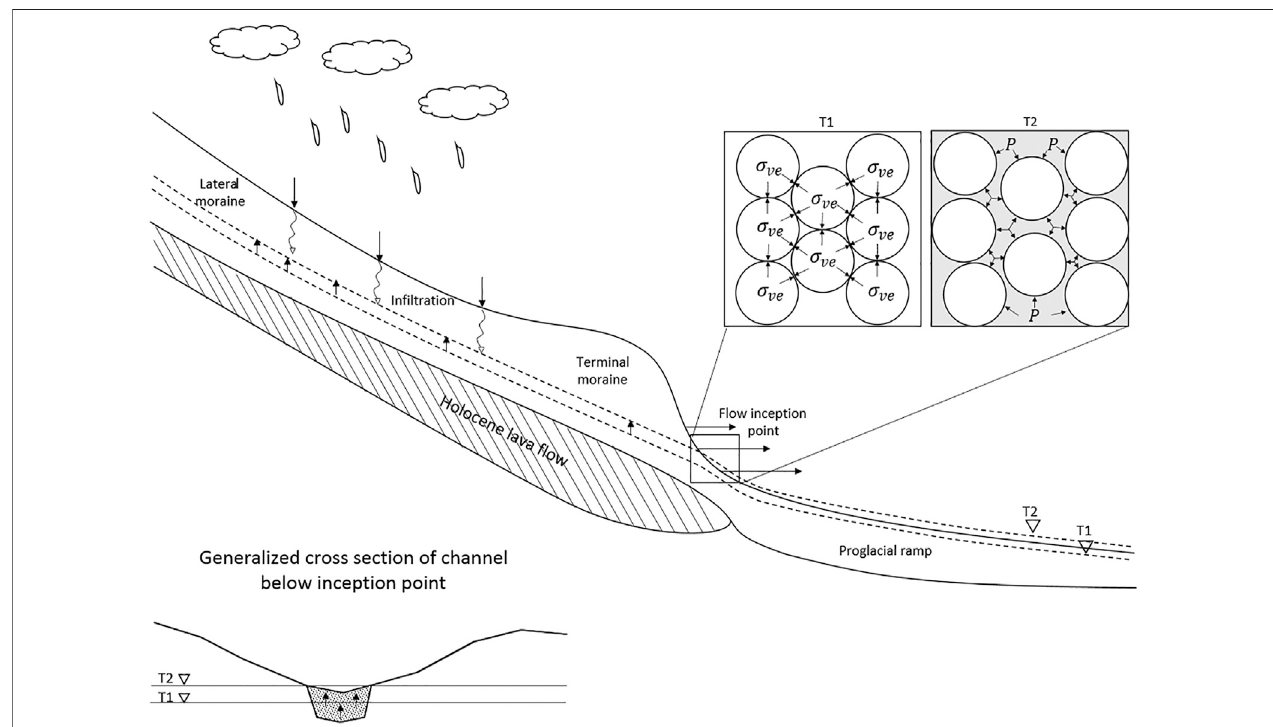
FIGURE11| Conceptualizedgraphicaldrawing,depictingalikelytriggeringscenariofortheobservedexcisionofthesedimentsintheproglacialrampchannel.The pre- and post- potentiometric surfaces (dashed lines) are shown as T1 and T2 in the longitudinal and transverse cross sections. The insets illustrate the opposing effective stress and pore water stress at grain